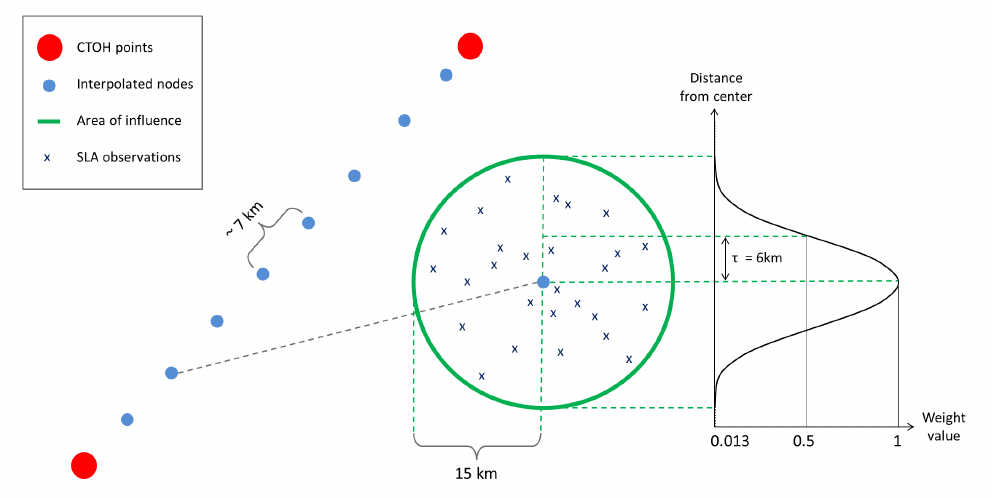
Figure 2. Scheme of the nodes and weighting process. From left to right: the nodes (pale blue) are located over the CTOH track points (red) with a distance of 7 km. For each node a circular area of interest is defined (green), and all the SLA observations (crosses) within this area are selected. The observations are weighted with a Gaussian function dependent on the distance from the